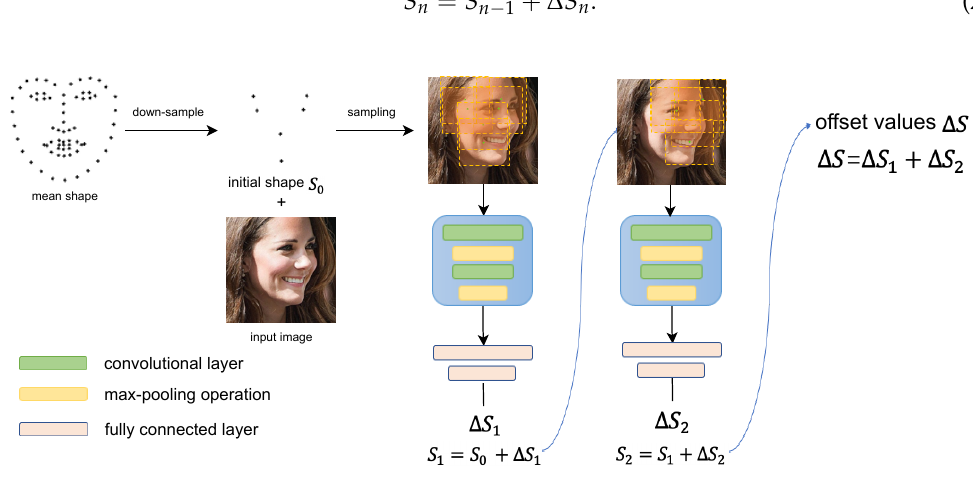
Figure 3. Sparselandmark detection